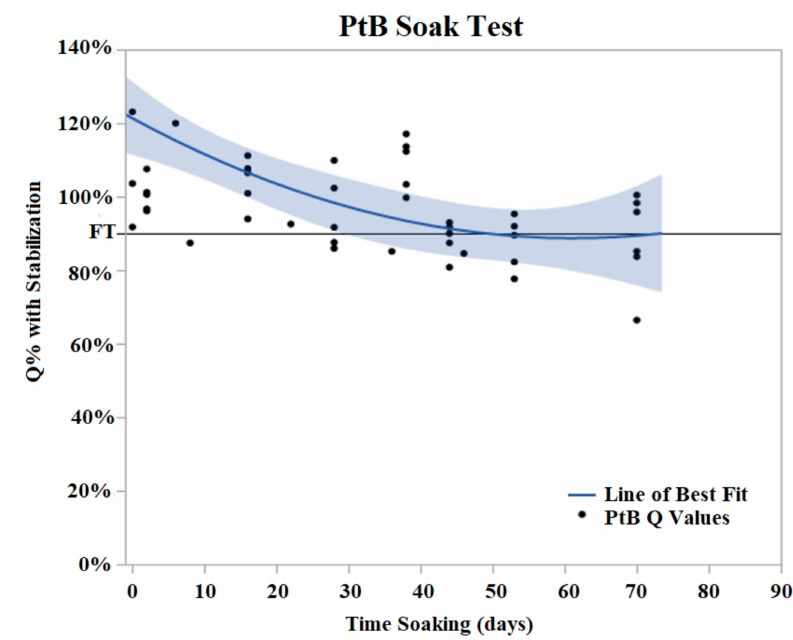
Figure 6. PtB soak trials were plotted as Q% with stabilized vs. time soaking (days) in. Stabilized values were derived from initial Q value analysis. A quadratic line of best fit was fit to the data (Y = 0.8979 + 0.00605x − 0.000152 × 2). The horizontal line at 90% represents the failure threshold. α =